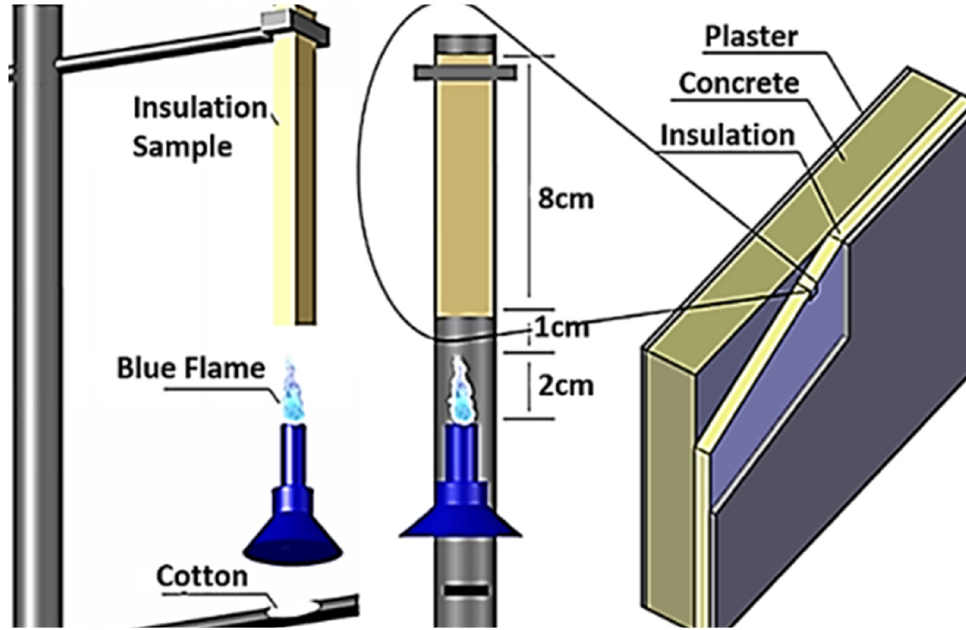
Figure 5. UL94 V experimental setup of flammability test for the puffed rice insulation sample.